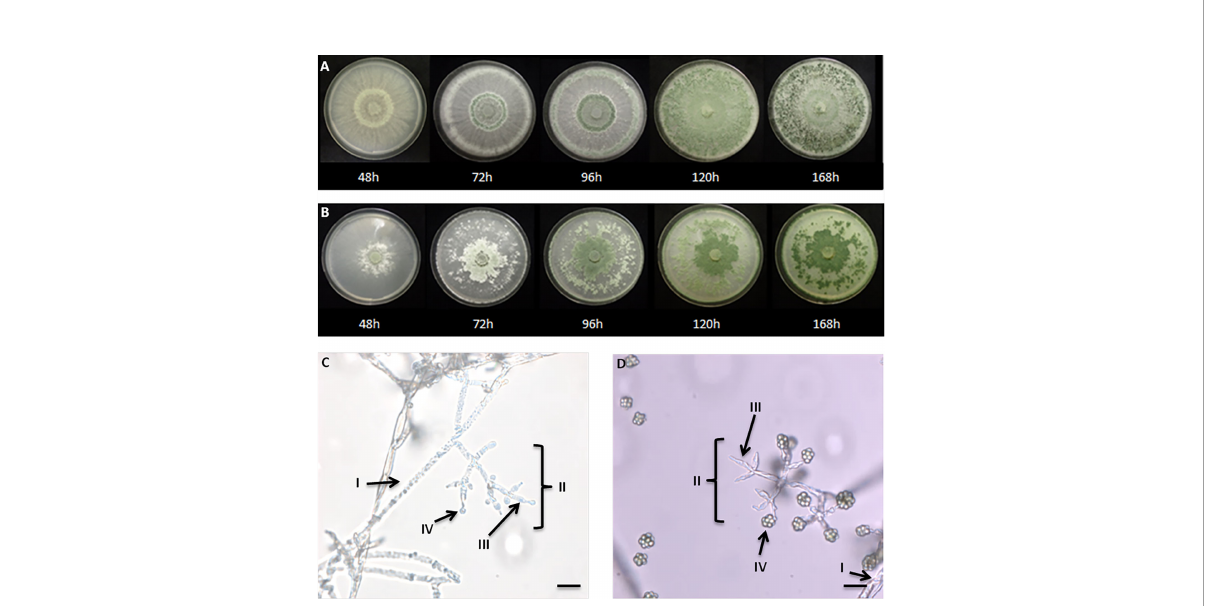
FIGURE 2 Growth of T. guizhouense (A) and T. afroharzianum (B) for one week on PDA supplemented with glucose. The age of the culture is indicated below the picture in hours. Microscopic visualization of conidiophores of T. guizhouense (C) T. afroharzianum (D) (x1000). (I) hyphae, (II) conidiophores, (III) Phialides and (IV) conidia (the scale bar corresponds to 10 m